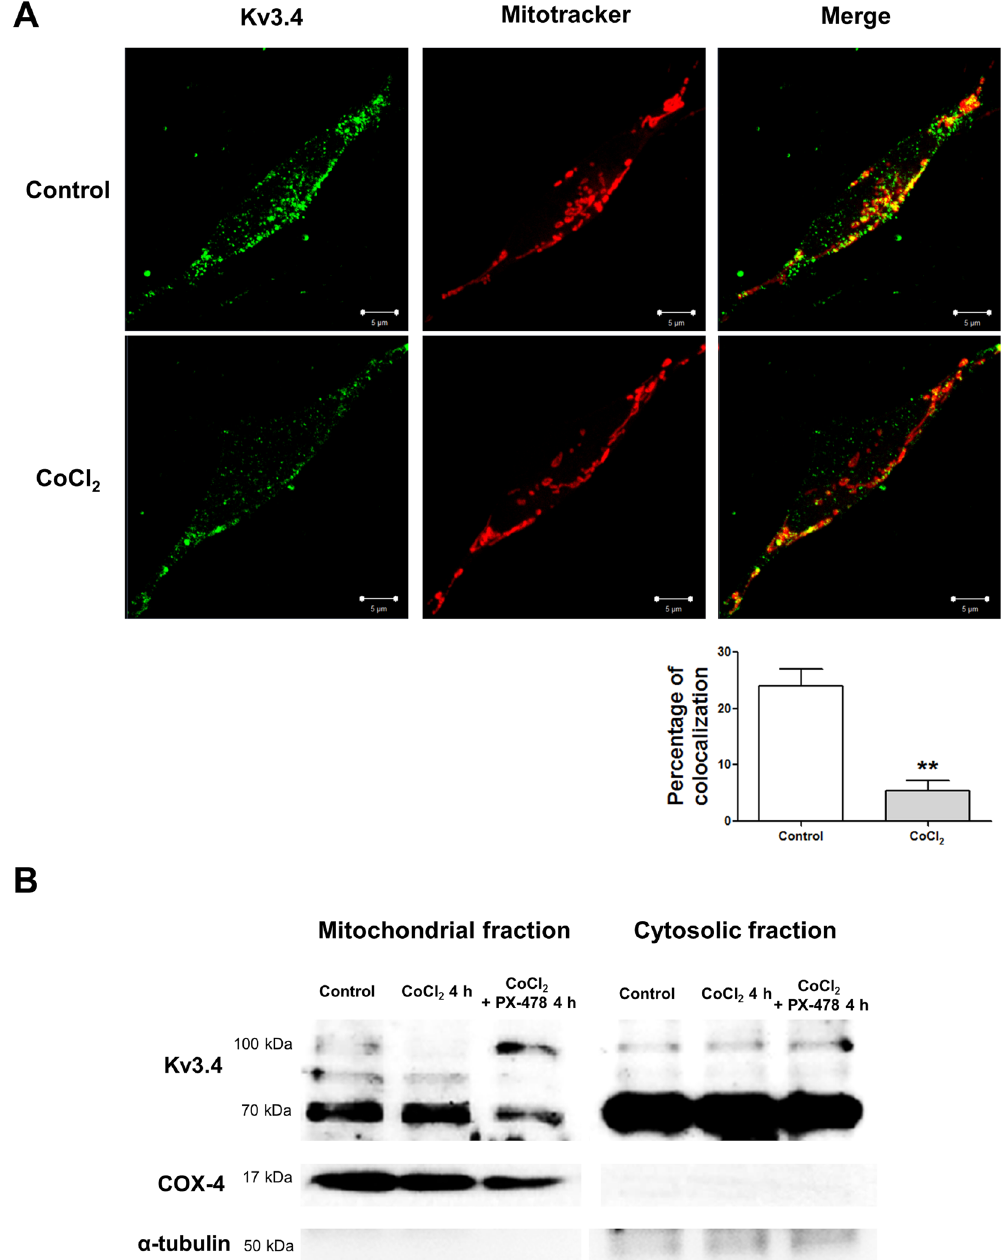
Figure 4. Mitochondrial Kv3.4 was more sensitive to CoCl 2 and PX-478 ( A ) Immunocytochemical analysis demonstrated that Kv3.4 co-localizes with mitochondria, and co-localized Kv3.4 decreased after 6 h of 100 µ M CoCl 2 treatment (green: Kv3.4, red: mitochondria, yellow: co-localization). We assessed five different images in each group (the control and CoCl 2 treatment groups) to avoid cherry-picking; representative images are shown. ( B ) Mitochondrial fractionation demonstrated that Kv3.4 is present in both the mitochondria and cytosol and that mitochondrial 100 kDa Kv3.4 is sensitive to CoCl 2 alone or CoCl 2 with PX-478 treatment. Kv3.4 (100 kDa) was down-regulated by 4 h of CoCl 2 treatment, whereas 4 h of PX-478 pretreatment followed by 4 h of CoCl 2 and PX- 478 treatment induced the accumulation of Kv3.4. COX-4 and α -tubulin are used as mitochondrial and cytosolic markers, respectively. All experiments were performed in quadruplicate; representative images are